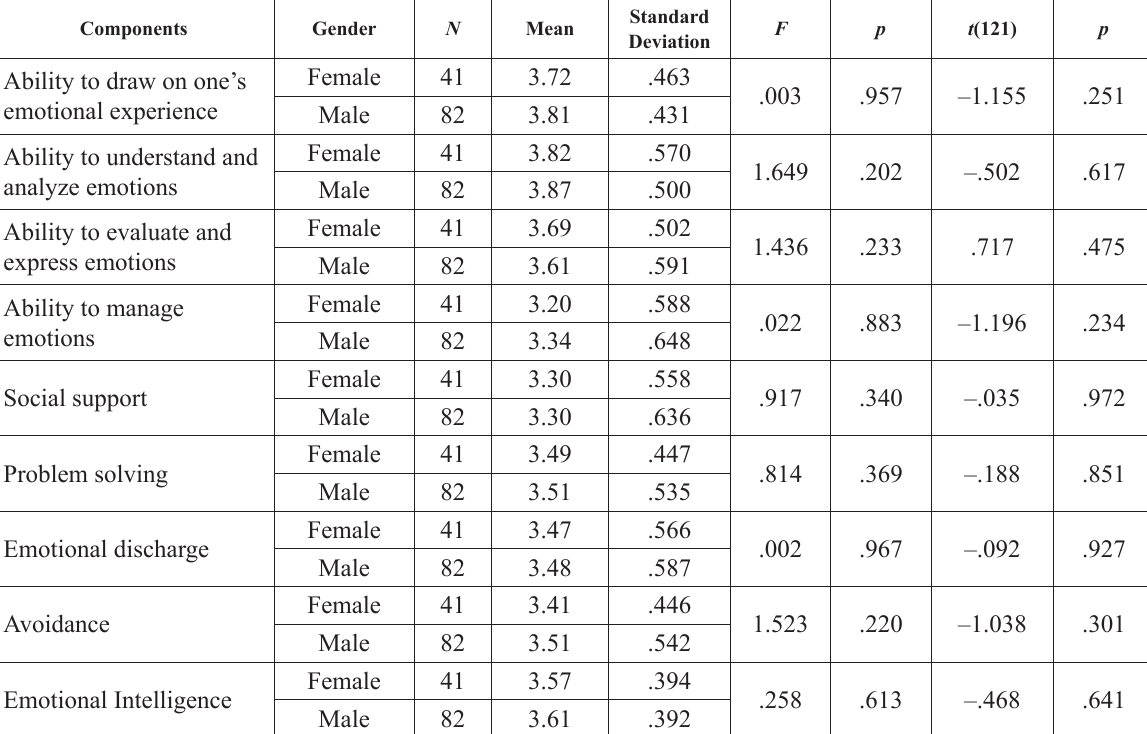
Table 2. Differences between the means of the estimates of emotional intelligence and stress coping strategies according to gender of